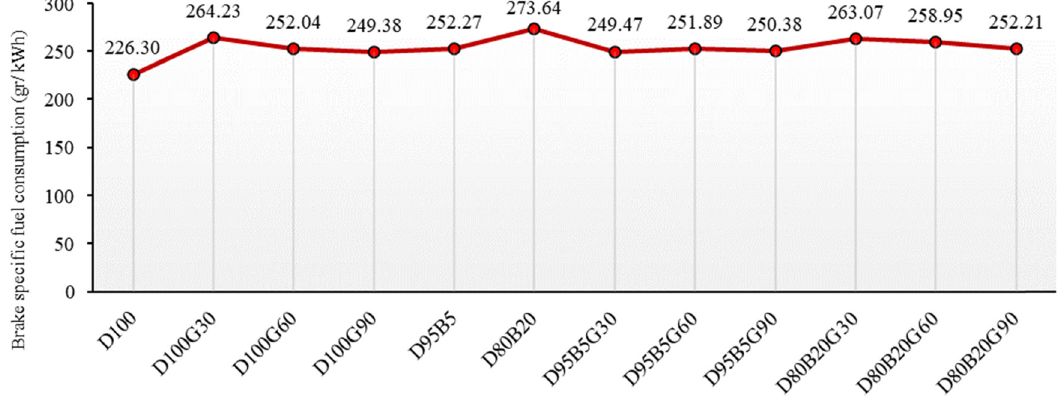
Figure 5: Variations in the BSFC for di ff erent fuel blends.